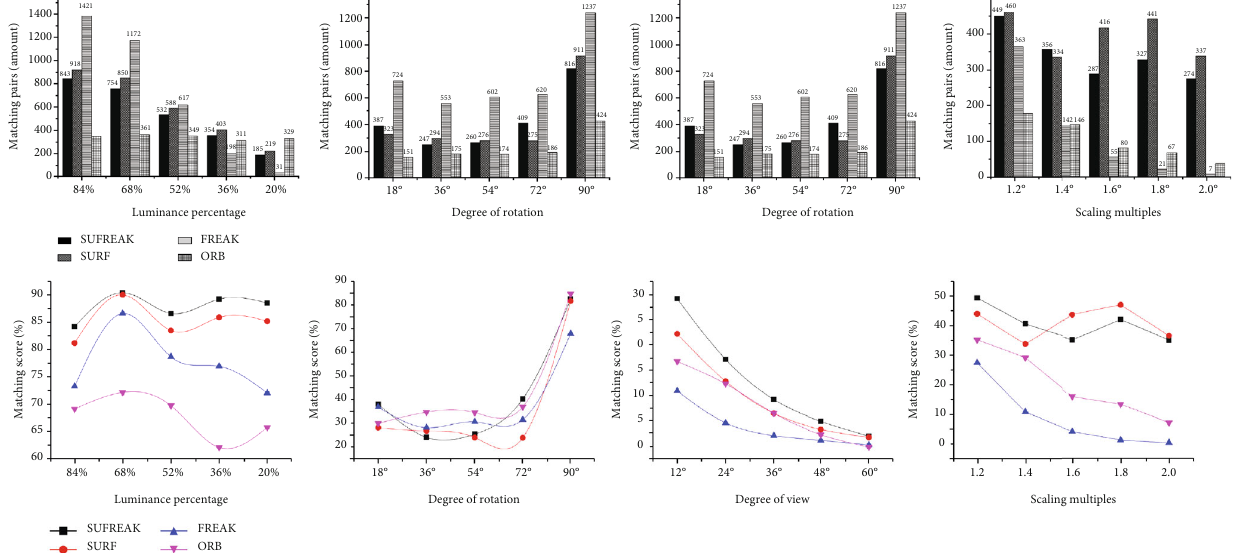
Figure 3: Comparison of matching point pair number and matching fraction curve in image transformation.